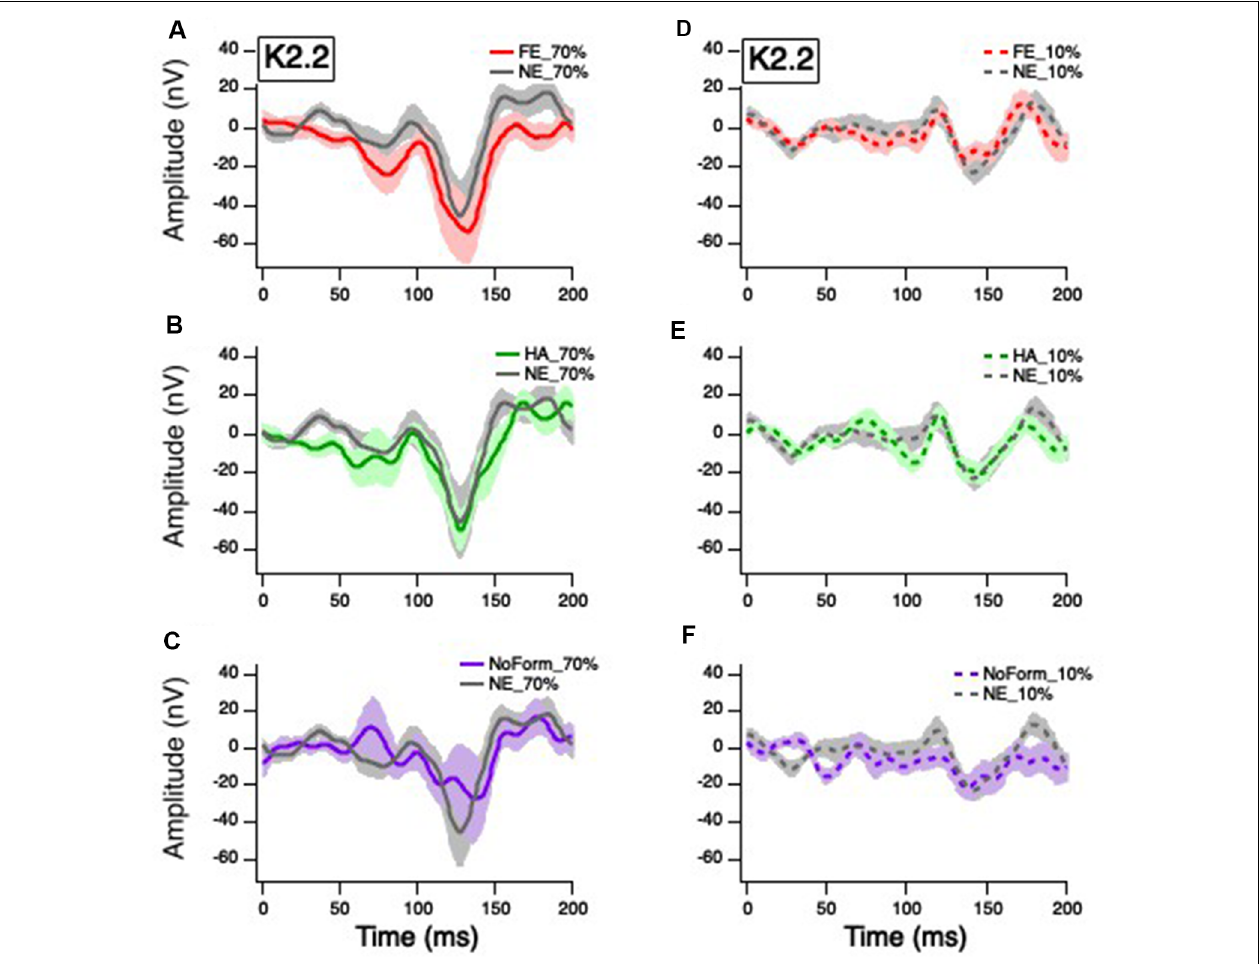
FIGURE 4 | Grand mean average K2.2 responses. Solid red, green, gray, and purple lines correspond to the averaged waveforms for the 70% temporal contrast conditions with (A) fearful, (B) happy, neutral, and (C) no form stimuli superimposed on the central patch, respectively. Dashed red, green, gray, and purple lines correspond to the averaged waveforms for the 10% temporal contrast conditions with (D) fearful, (E) happy, neutral stimuli, and (F) no form superimposed on the central patch,